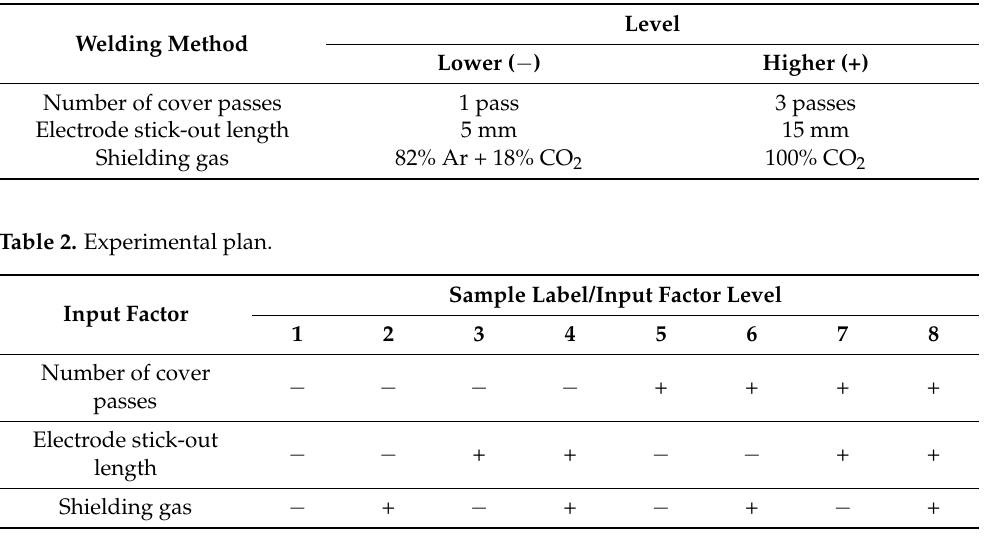
Table 1. Welding methods that were changed during the experiments.